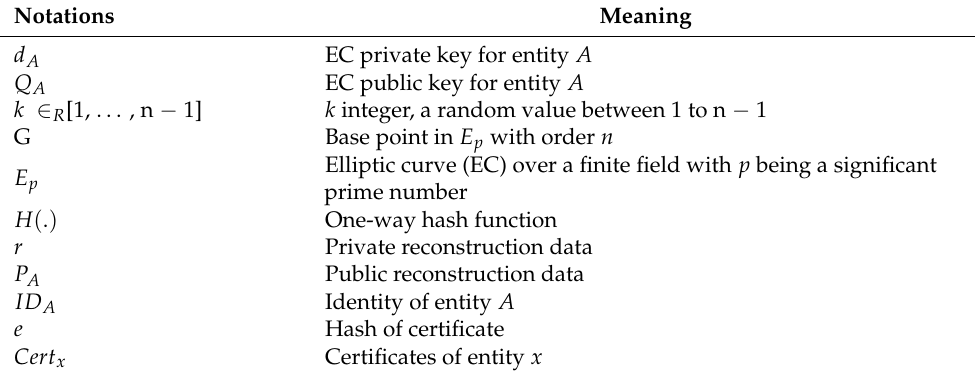
Table 1. ECQV basic notations.